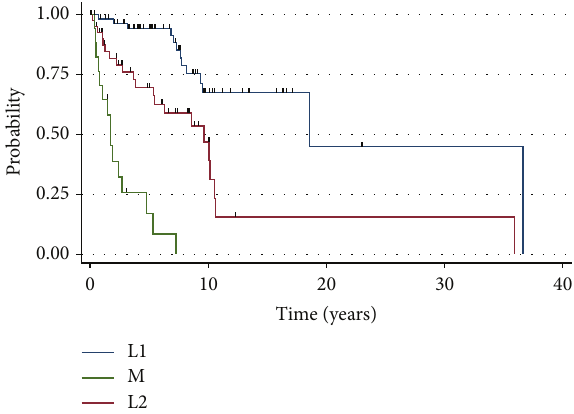
Figure 1: Overall survival of adult neuroblastoma patients by stage of disease. 𝑃 < 0.001 .